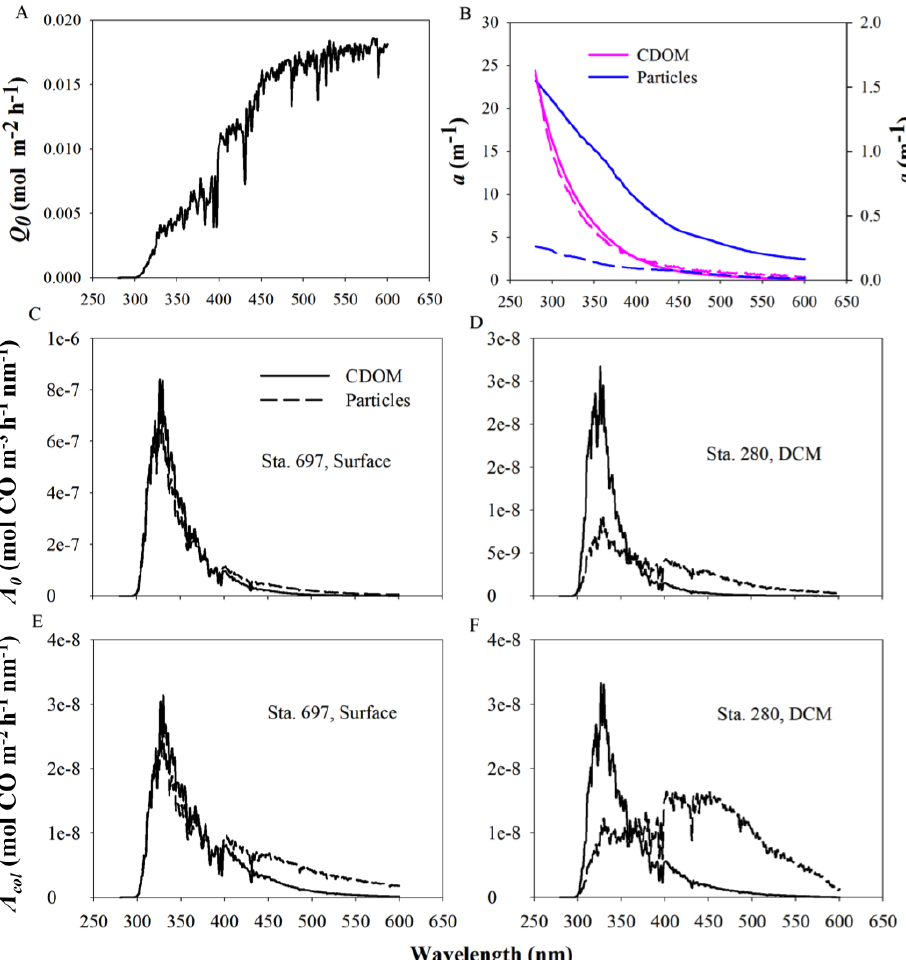
Fig. 5. Modeled surface spectral solar irradiance (A) , a cdom and a p (B) , surface CO action spectra ( C and D ) and depth-integrated CO action spectra ( E and F ). In (B) , left y-axis is for Sta. 697 (solid line) and right y-axis for Sta. 280-DCM (dashed line).